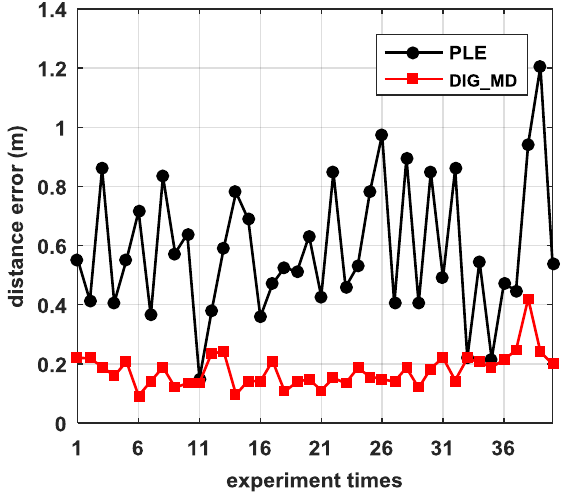
Figure 13. The localization error for 30 repetition estimation results.